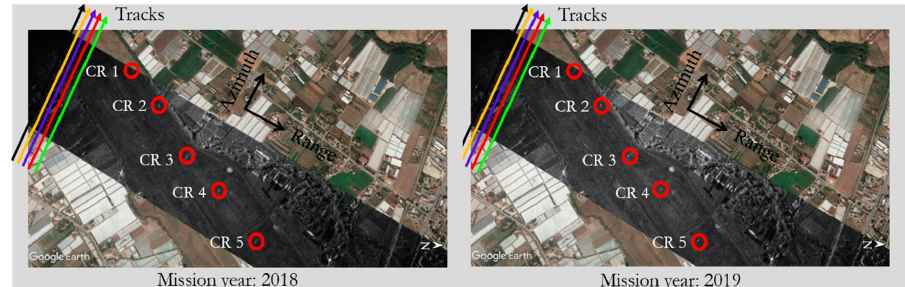
Figure 5. As Figure 2, but relevant to the Experiment 5 (left) and Experiment 6 (right). Number of exploited CRs (red circles): 5. Number of exploited tracks (colored lines): 5. Mission year: 2018 for Experiment 5 and 2019 for Experiment 6. The different flown tracks, which are almost overlapped, are depicted well separated just for graphical purposes.